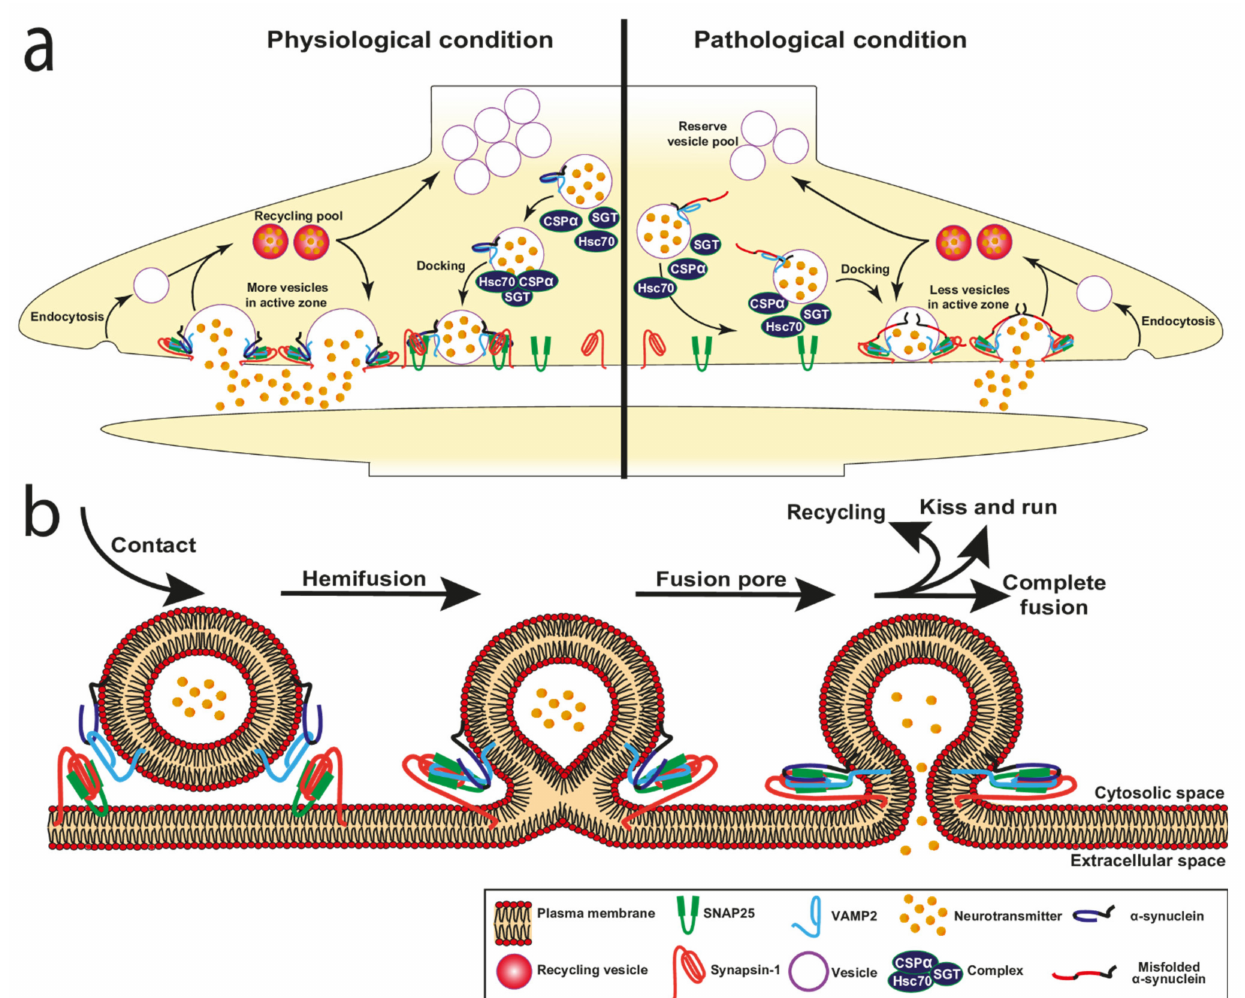
Figure 3. Schematic hypothesis of the role of α -synuclein ( α -syn) in exocytosis. ( a ) α -syn, under physiological condition ( left panel), interacts with the soluble N-ethylmaleimide-sensitive-factor attachment protein receptor (SNARE) vesicle- associated membrane protein 2 (VAMP2) on the synaptic vesicles (SV) surface, drives the docking of the SV to the active zone and regulates the formation of the tripartite SNARE-complex. Others synaptic partners including synapsin-1 and complexin act in the complex stabilisation. The SNARE-complex regulates the fusion of the SV with the synaptic membrane. After cargo release, the vesicles are recycled. Under pathological condition ( right panel) aberrant forms of α -syn have a stronger binding affinity for VAMP2. The reduced availability of unbound VAMP2 molecules inhibits the SNARE complex formation and reduces the number of vesicles in the active zone. ( b ) α -syn actively participates in exocytosis by regulating SNARE complex formation and vesicle fusion events. Indeed, α -syn favours dilatation/closure of the fusion pore as well as regulates the kiss and run exocytosis. SNAP25 = synaptosome associated protein 25, CSP α = cysteine-string protein- α , Hsc70 = heat shock cognate 70, SGT = small glutamine-rich tetratricopeptide repeat-containing protein α